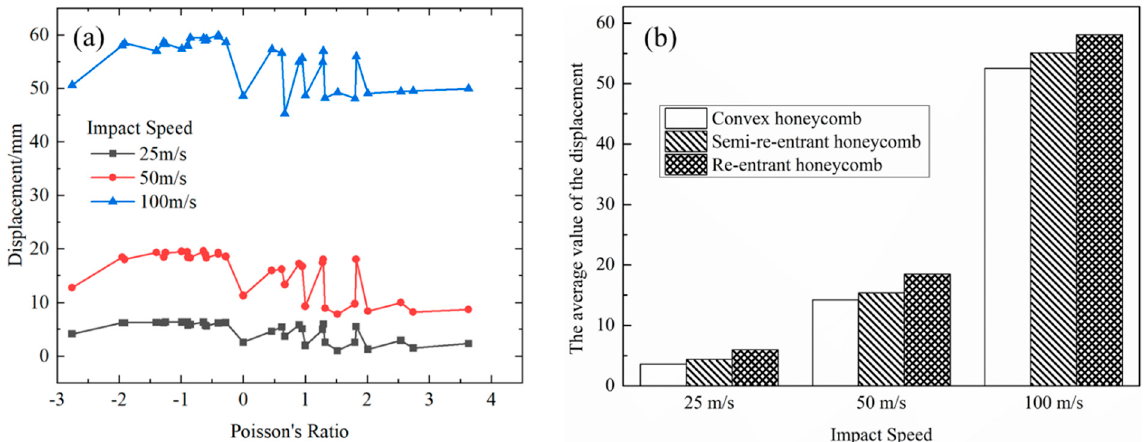
Figure 6. The rear face sheet displacement of the honeycomb sandwich structure with different Poisson’s ratios: ( a ) displacement; ( b ) the average value of displacement.